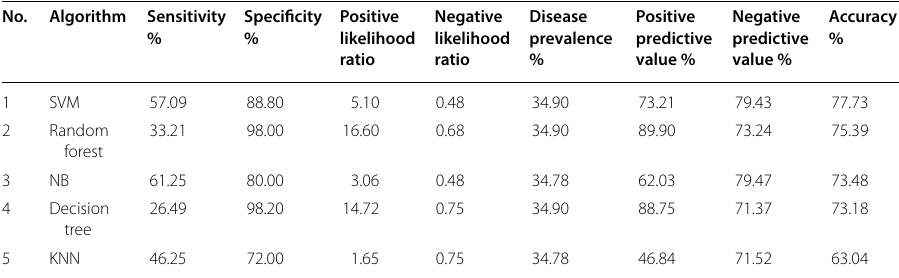
Table 8 Comparison of classification technique No. Algorithm Sensitivity %